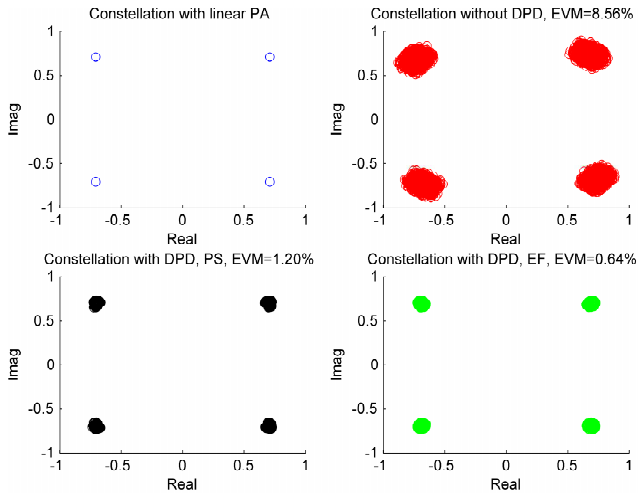
Figure 6. Output constellation of the ideal linear PA, the Wiener PA model without DPD, with DPD under configuration obtained from PS and